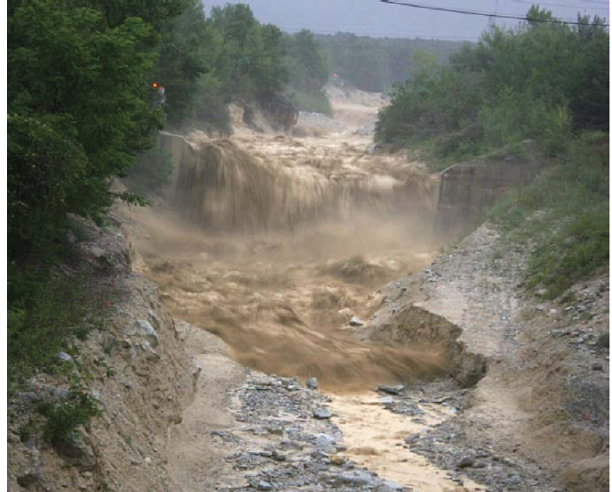
Figure 2. Photo of Illgraben debris-flow event near check dam 28. Source: Brian McArdell,